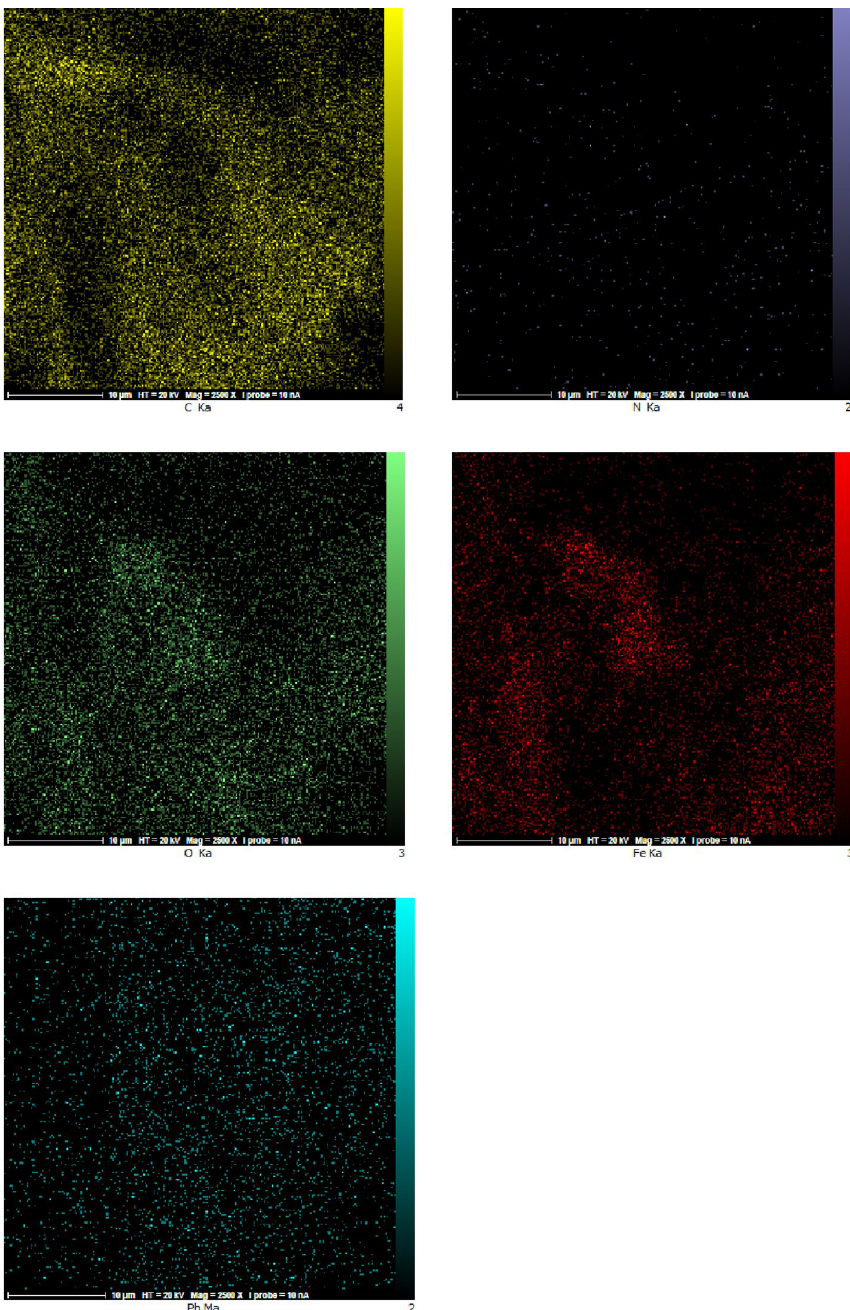
Figure 8. EDAX Mapping of elements in Pb 2+ ions adsorbed Pip@MGO